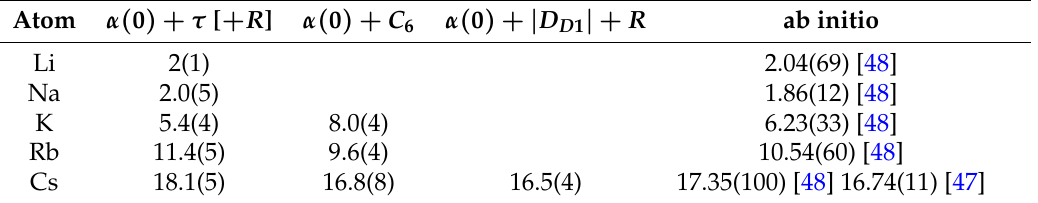
Table 5. α r ( 0 ) values deduced by combining α ( 0 ) measurements [3–5,7,42] with either C 6 measurements